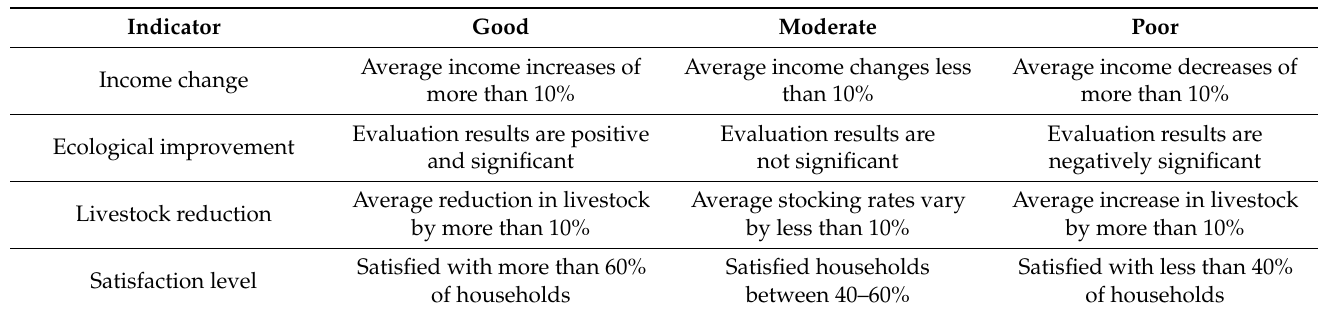
Table 2. Grading criteria for compensation effects.